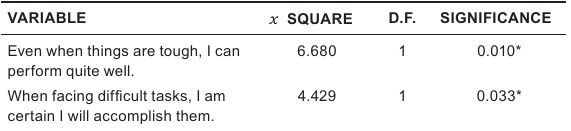
table 5 Chi-square-based measures of association between new ventures, small business and entrepreneurship are distinctly different disciplines or have much in common, especially the need for sharp